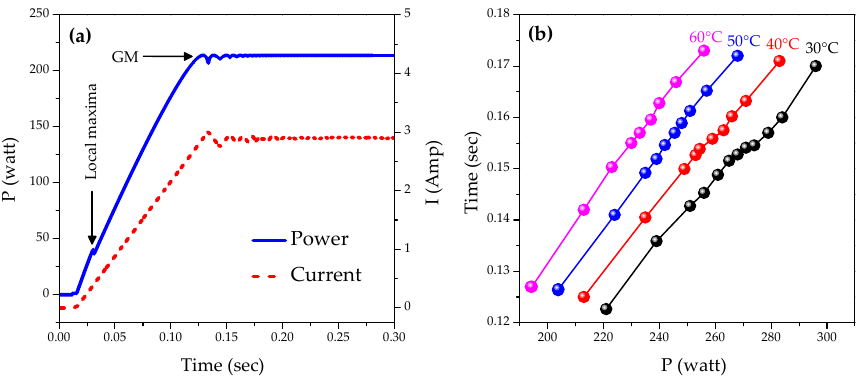
Figure 8. ( a ) The power and current as a function of time during MPPT functioning in order to find the GM in partial shading; ( b ) the GM search time as a function of power at different temperatures.